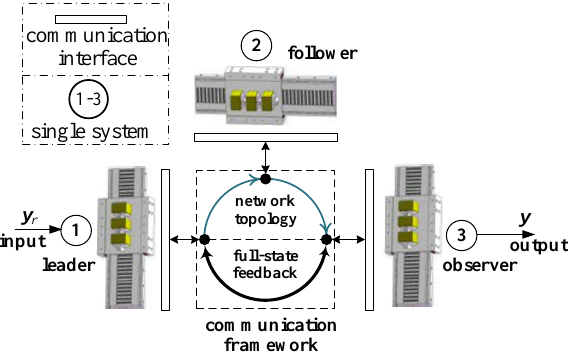
Figure 7. Hardware construction of LSRM network.